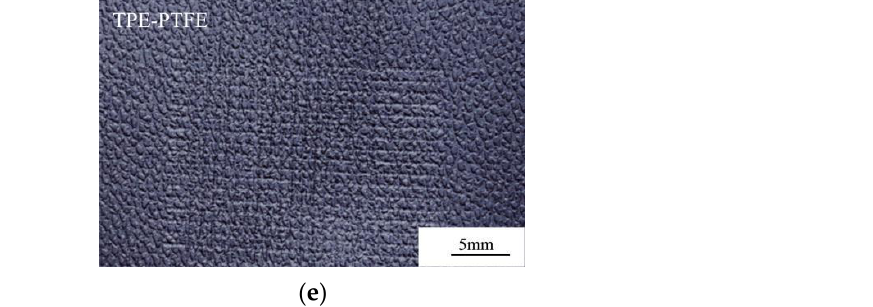
Figure 11. Cross scratch samples of TPE prepared by various lubricating agents and masterbatches. ( a ) TPE-HG650; ( b ) TPE-SR100B; ( c ) TPE-18K; ( d ) TPE-H/LSi; ( e ) TPE-PTFE.